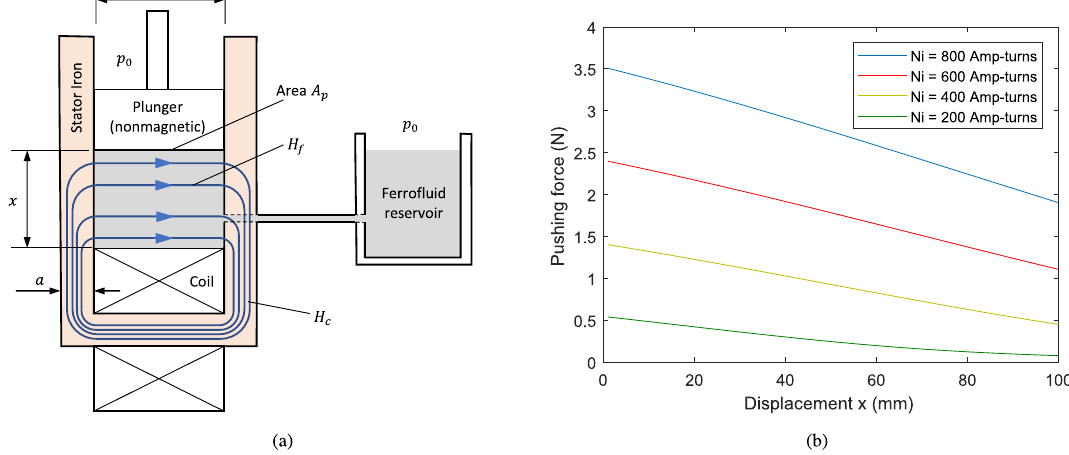
Figure 8. Example actuator system with orthogonal-field mode operation (Case 2): ( a ) schematic; ( b ) force